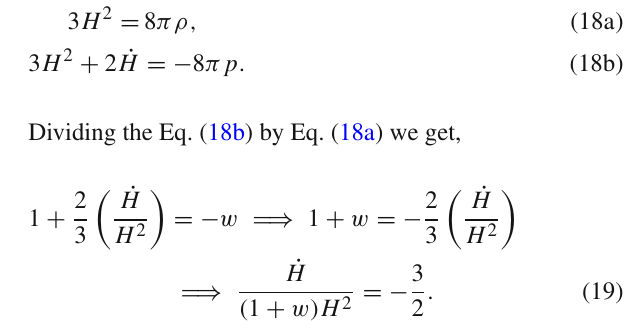
ρ (cid:2) 2 C T 4 π ˜ r 2 A